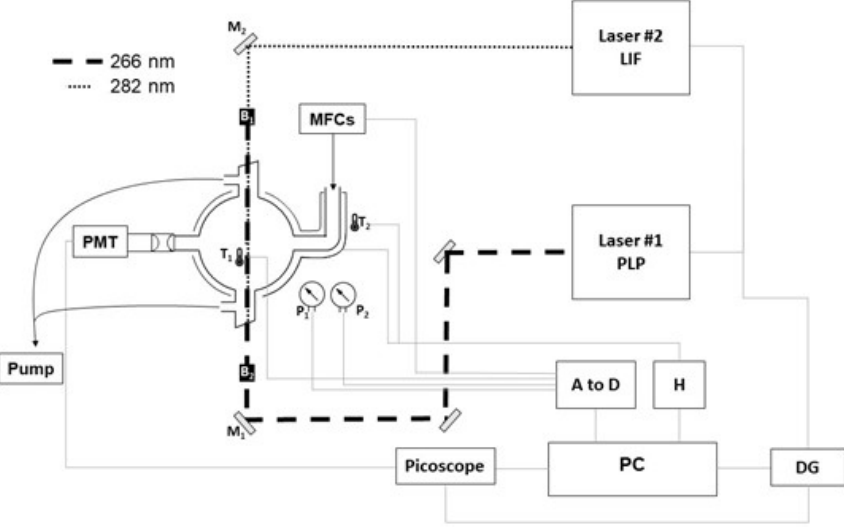
Figure 2. Schematic of the PLP–LIF apparatus. Key: Laser#1 – 266nm YAG for PLP OH generation; Laser#2 – 532nm YAG-pumped dye, frequency doubled for output at 282nm for OH LIF detection; M1 – 266nm dichroic mirrors; M2 – 282nm dichroic mirror; B1 and B2 – beam stoppers; T1 and T2 – thermocouples; P1 and P2 – 1000 and 10Torr pressure gauges; DG – delay generator; H – thermal control box; A to D – analogue to digital converter to allow for PC control of gas flows and logging of cell temperature and pressure.